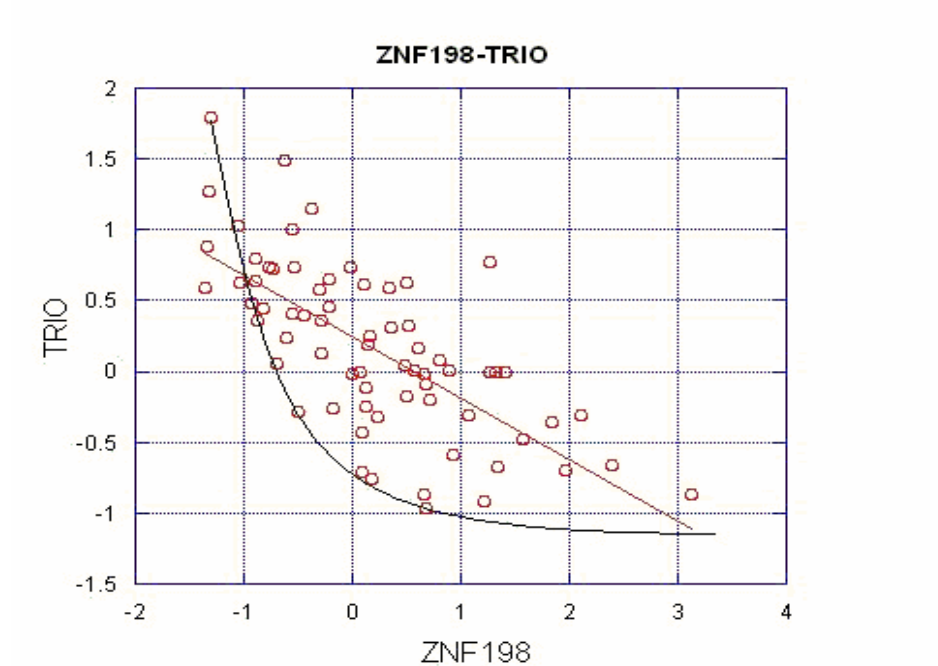
Figure 2: Illustration for negatively correlated TF-gene regulation